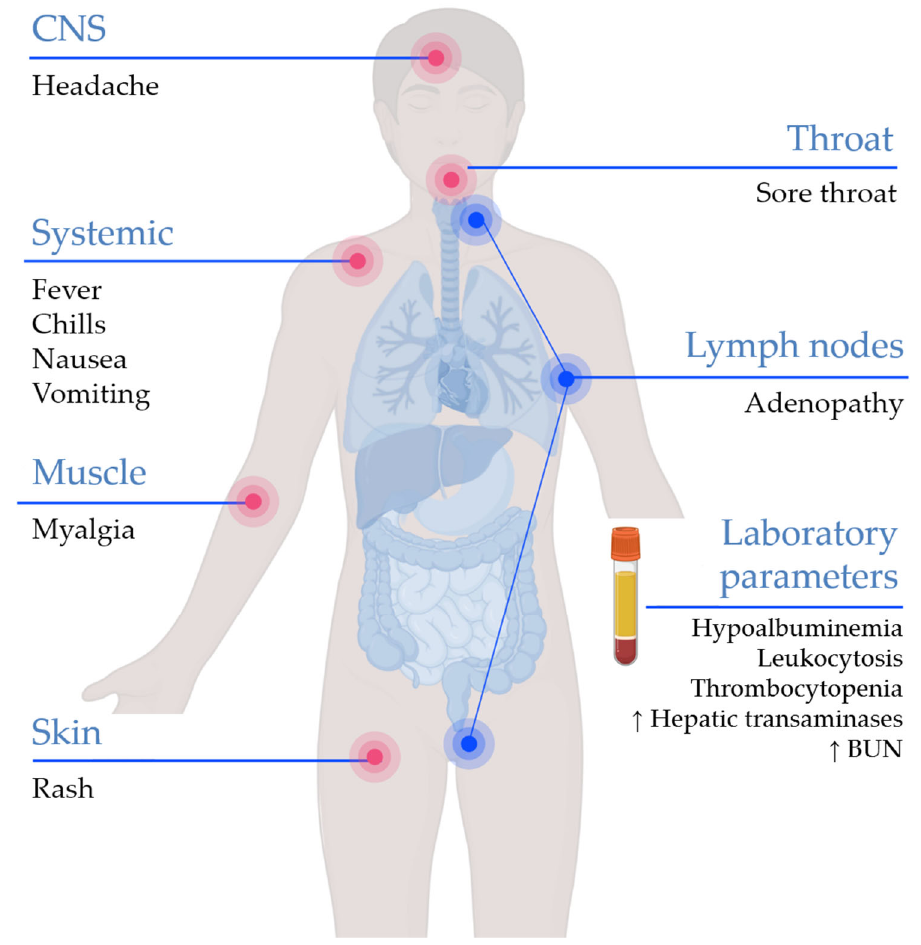
Figure 5. The clinical and laboratory features of monkeypox. BUN: blood urea